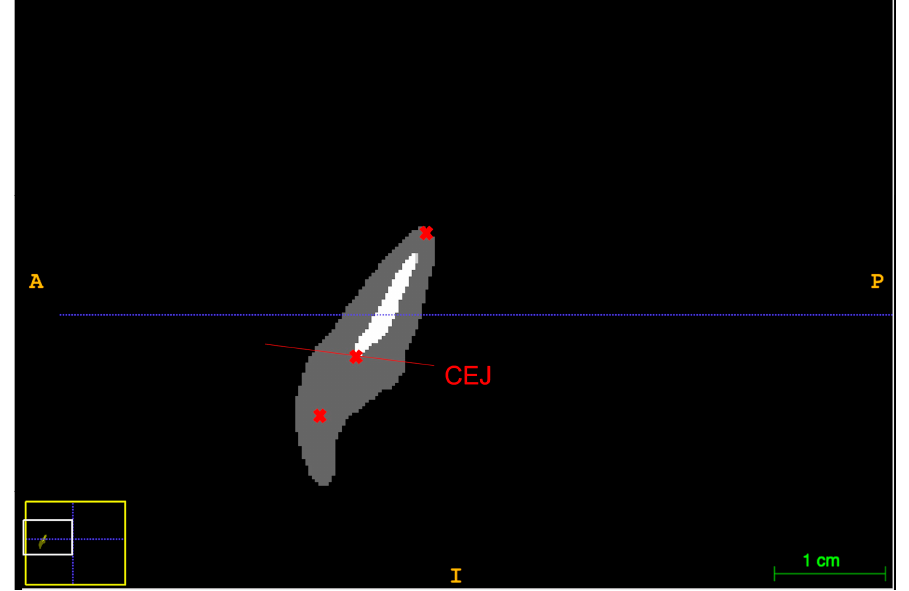
Figure 1. Pulp volume measurement using the ITK_SNAP software. X red: endpoints of the measurements; Red line: Cement-enamel junction.